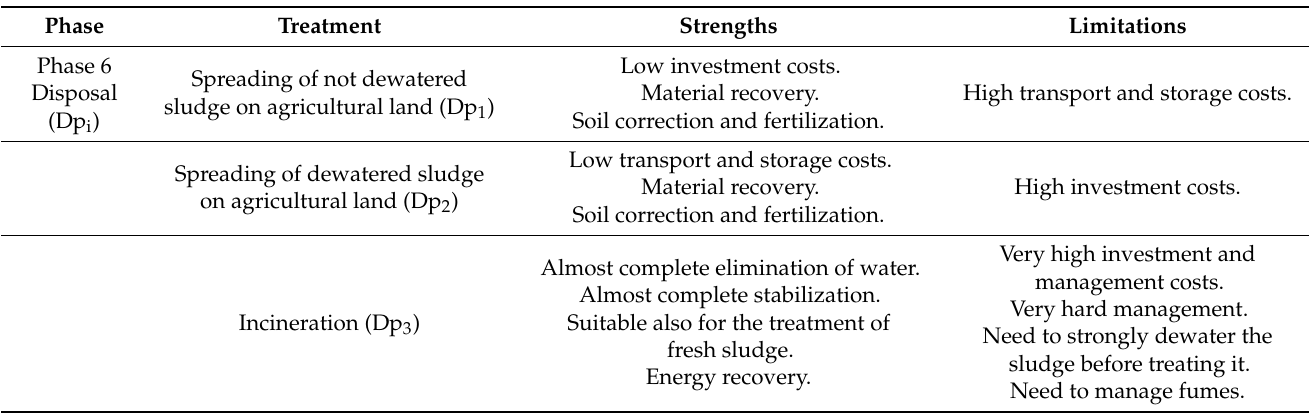
Table 6. Strengths and limitations of all considered alternatives to carry out the disposal treatments of the modeled SSTS.